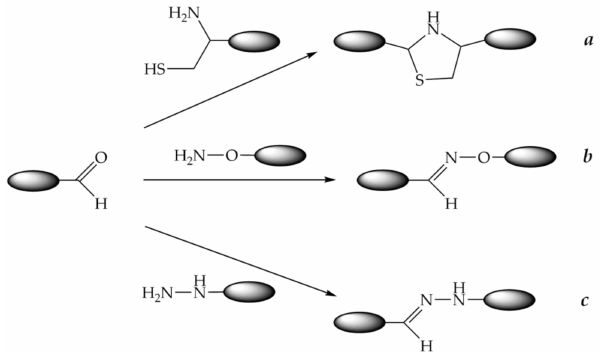
Figure 12. Conjugation through thiazolidine ( a ), oxime ( b ), and hydrazone ( c ) bonds, respectively. Several phosphoramidite reagents for the introduction of masked aldehyde precursors, such as 1,2-aminoalcohol (Figure 13a), 1,2-diol (Figure 13b), or acetal (Figure 13c), onto the 5 (cid:48) -end of an oligonucleotide during solid-phase synthesis have been developed [272–274]. The release of glyoxylic acid amide or aliphatic or aromatic aldehyde groups was carried out after the end of oligonucleotide synthesis after usual ammonia deprotection by treatment with acetic acid, followed by periodate ion oxidation (Figure 13a,b).